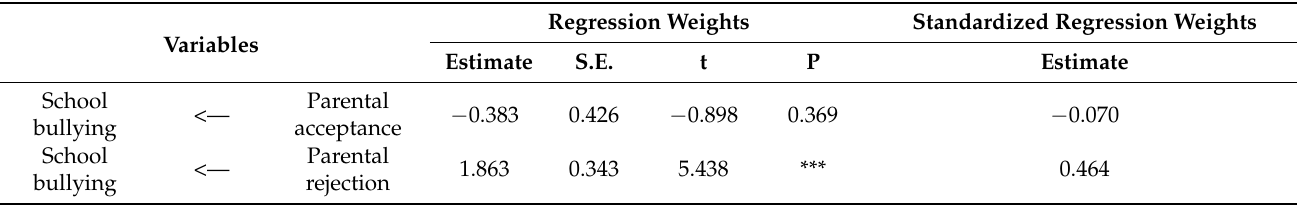
Table 5. Estimates of the effect of parental acceptance and rejection on school